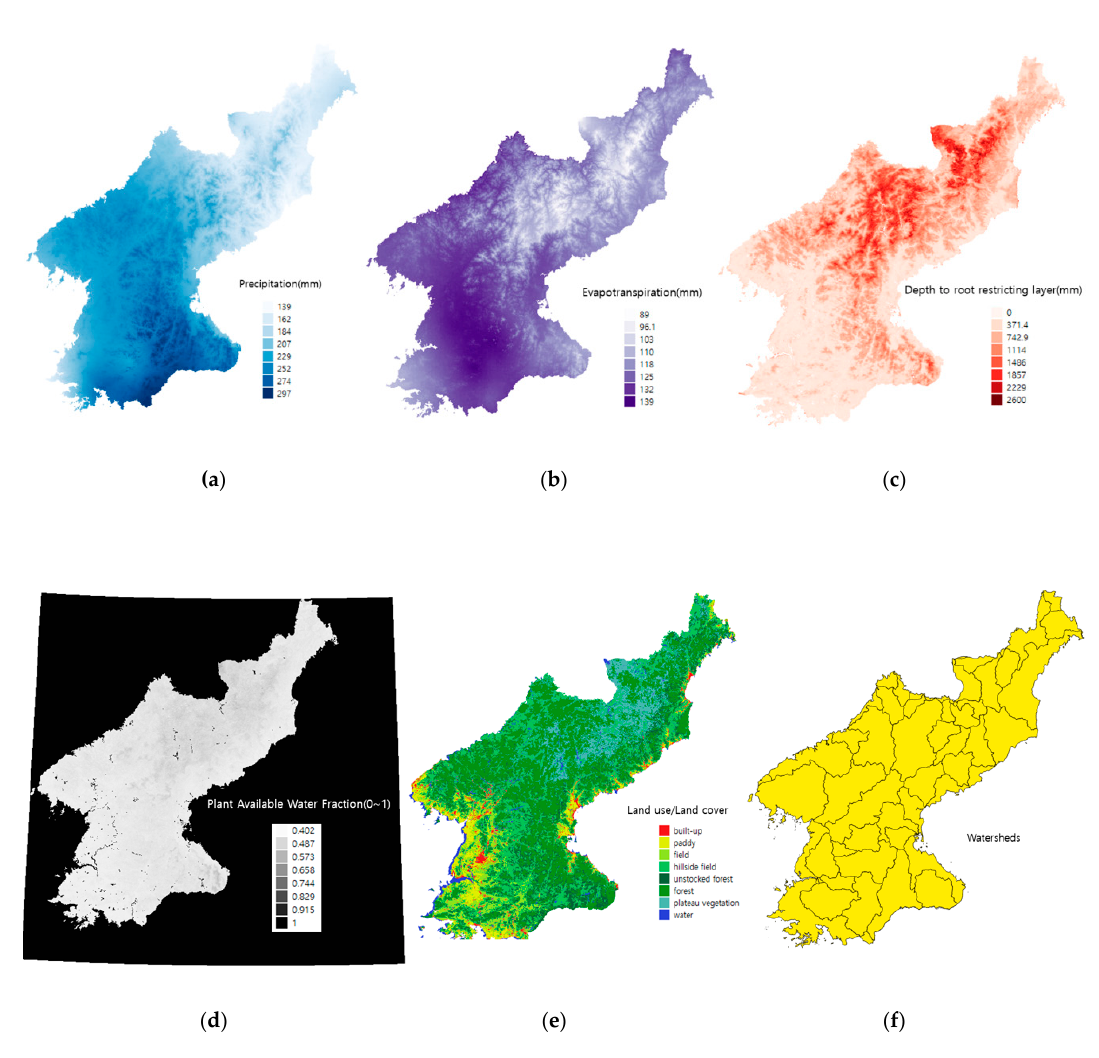
Figure 2. Input datasets constructed for Integrated Valuation of Ecosystem Services and Tradeoffs (InVEST) water yield modeling, ( a ) precipitation (mm), ( b ) evapotranspiration, ( c ) depth to root restricting layer, ( d ) plant available water fraction, ( e ) land use and land cover (LULC) and ( f ) 60 watersheds.